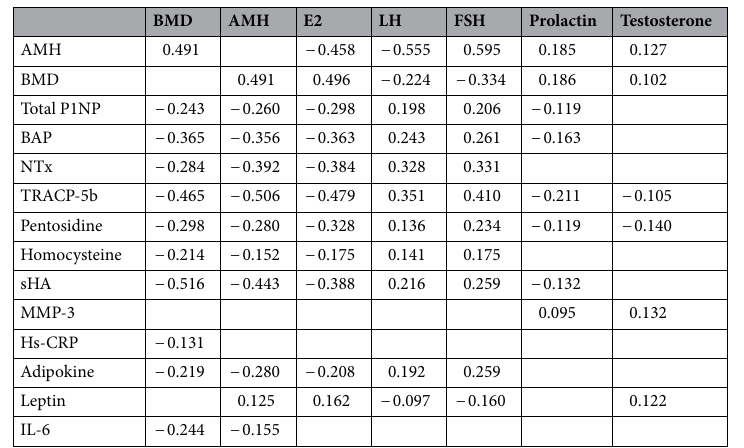
Table 4. Correlation coefficients among biomarkers of female hormones, bone metabolism, and inflammation. Spearman’s correlation coefficients were calculated. Only statistically significant correlations ( p < 0.05) were shown in this table.